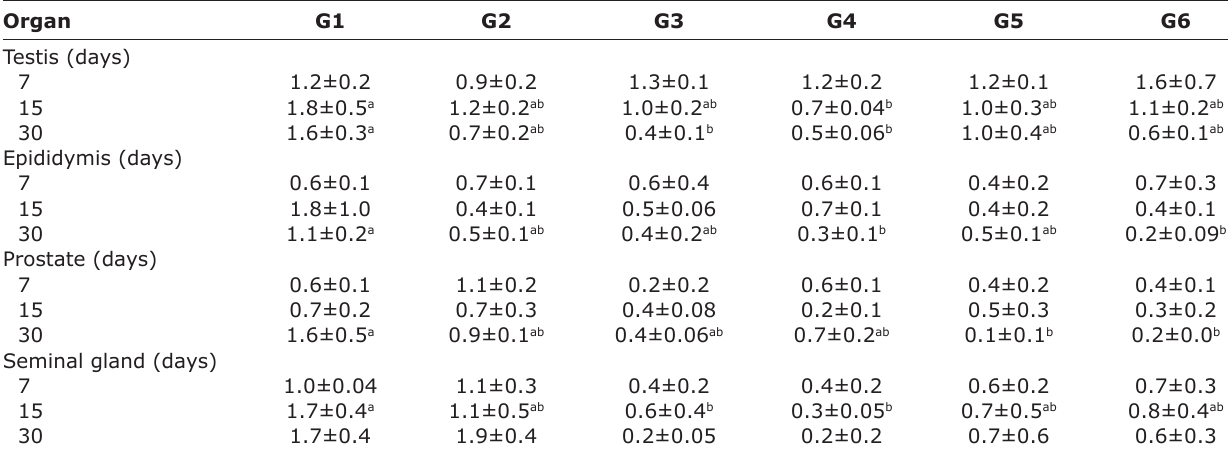
Table-2: Weight of testis, epididymis, prostate, and seminal gland (g) of Wistar rats treated with intratesticular injection of zinc gluconate and evaluated at 7, 15, and 30 days after treatment. G1 (saline), G2 (DMSO), G3 (zinc+dipyrone), G4 (zinc+celecoxib+dipyrone), G5 (zinc+meloxicam+dipyrone), and G6 (zinc+dexamethasone+dipyrone). Organ